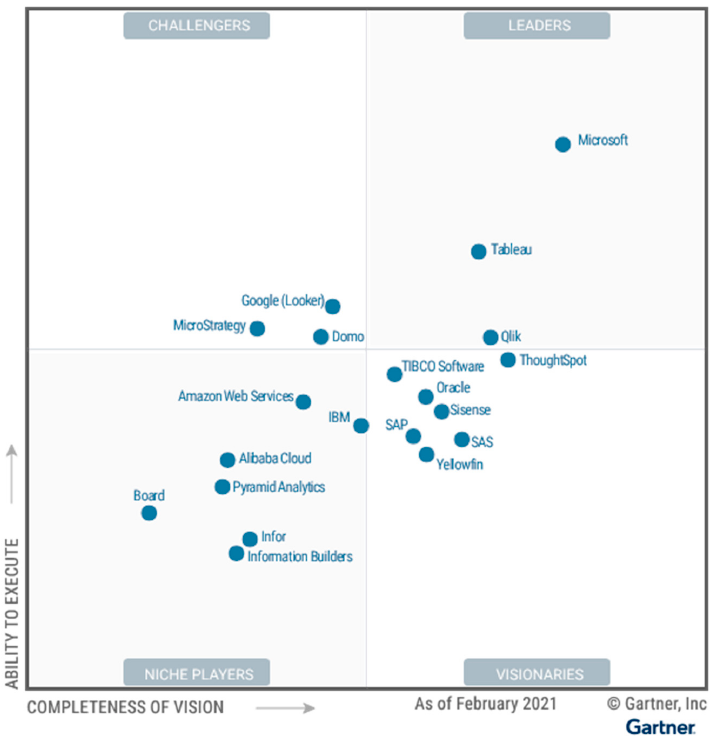
Figure 1. Gartner quadrant with the visualization tools considered as leaders in 2021. Considering the tools in the Gartner graph, an analysis of the main characteristics of the three tools found in the leaders’ quadrant was carried out. Table 1 presents a compar- ison of the selected platforms. Table 1. Analysis of the leading tools in visualization based on the characteristics necessary in sen- timent analysis.